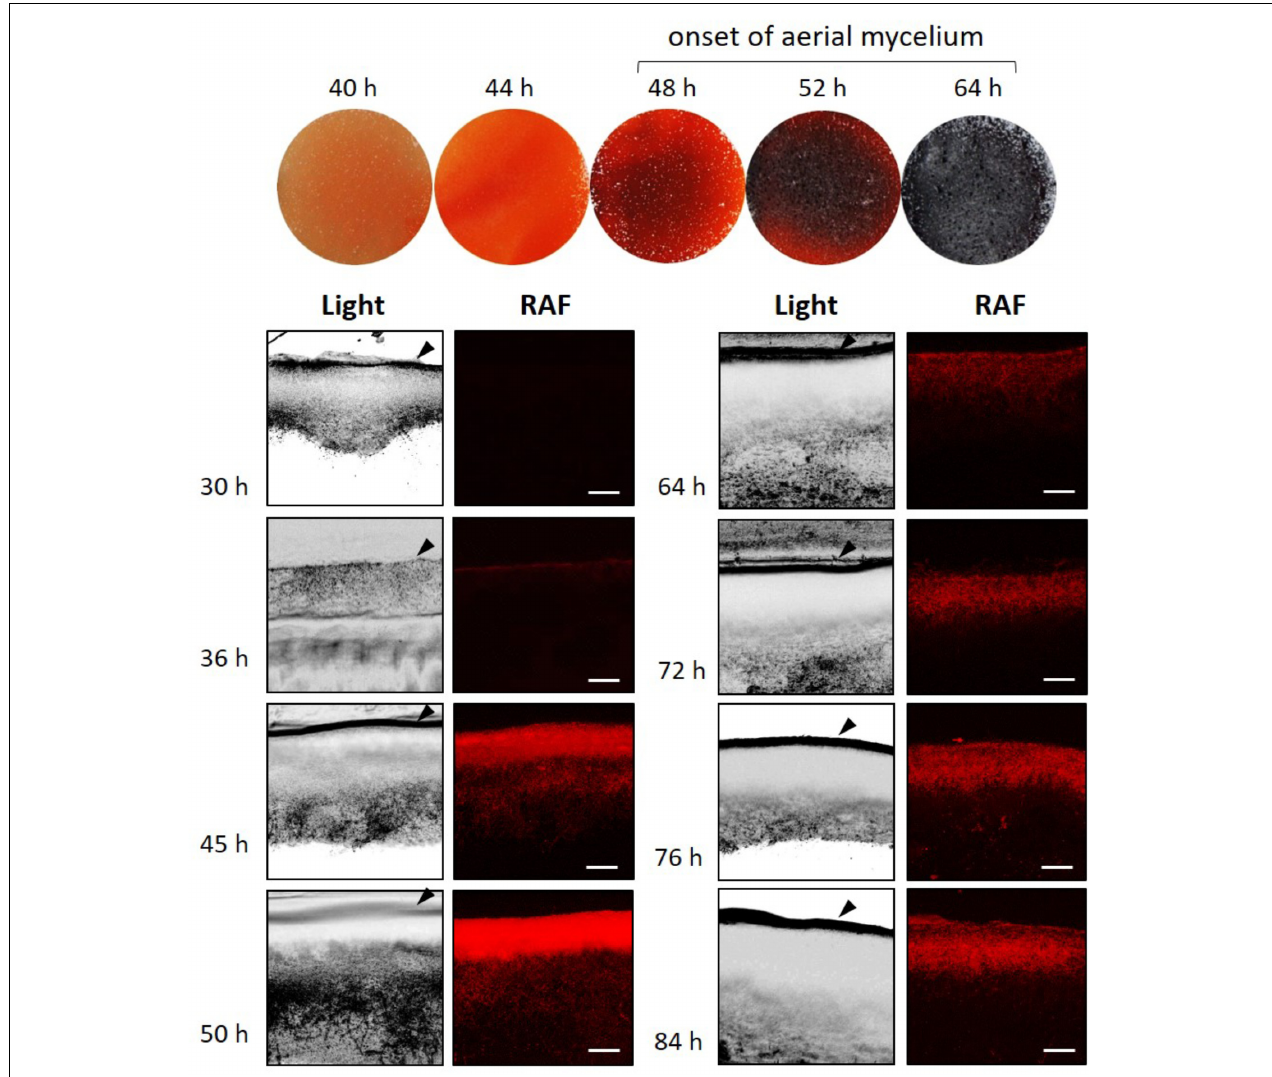
FIGURE 1 | Visualization and quantification of RAF throughout the life cycle of Streptomyces coelicolor . In situ visualization of RAF by confocal microscopy in cross section of a confluent S. coelicolor culture on R2YE agar plates. Bars, 40 µ m. Arrows indicate the surface of the agar plate cultures. Phenotypes of S. coelicolor grown in R2YE agar plates are shown to visualize the delay between the onset of PdG production and the onset of the morphological differentiation (white mycelium appearing on the surface of the